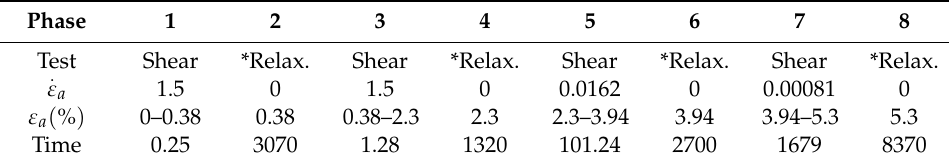
Figure 9. Comparison of observed and predicted triaxial compression test results of the Shanghai Clay ( a ) deviatoric stress-axial strain and ( b ) stress path. Table 3. Stress relaxation test on the San Francisco Bay Mud